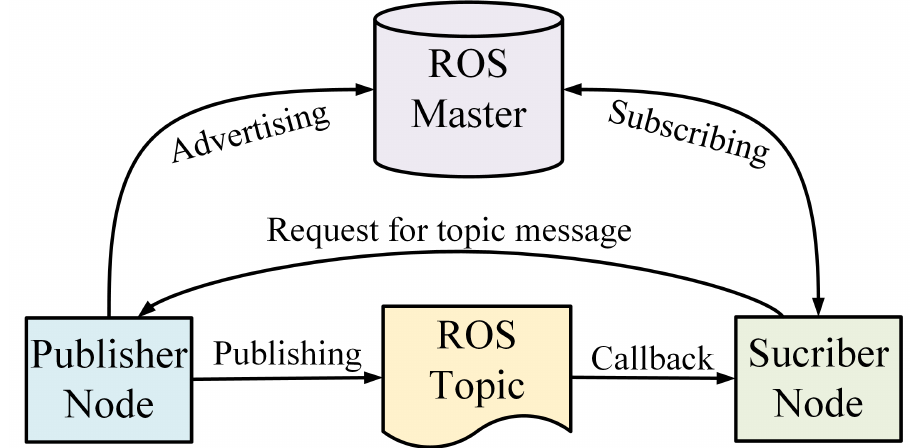
Figure 3. A typical ROS Model: System